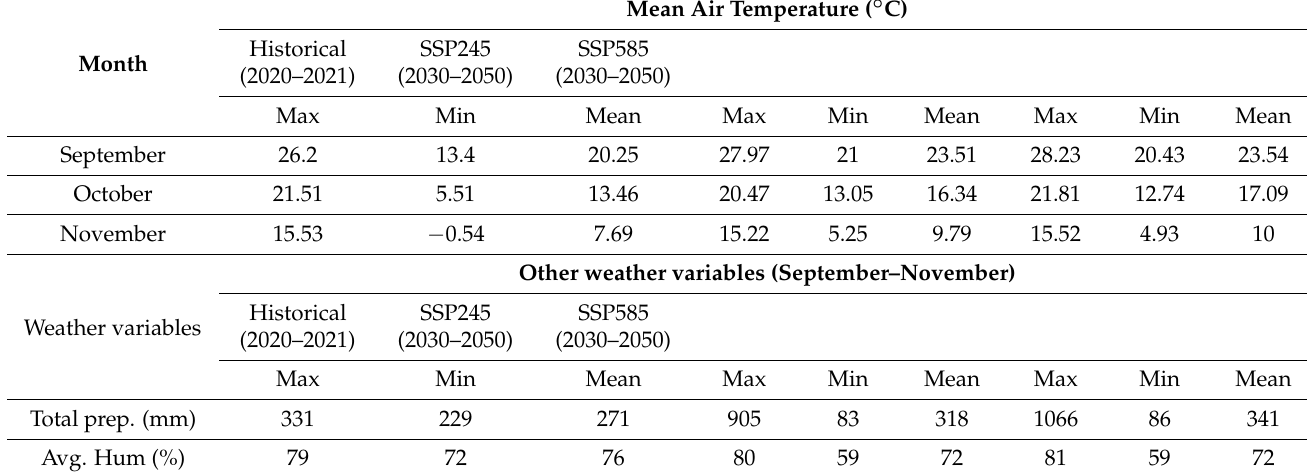
Table 5. Maximum, minimum, and average values of mean air temperature, total precipitation from September to November, and average air humidity (%) from September to November in the historical period (2020–2021) and future period (2030–2050) under two climate scenarios, SSP245 and SSP585, among all the simulated sites in all seven provinces, South